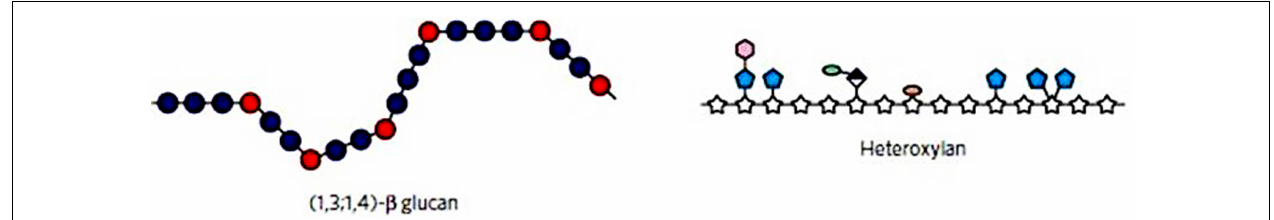
alignment and microfibril formation. In the heteroxylan (right) , intermolecular alignment of the xylan backbone (stars) and microfibril formation is limited by steric hindrance afforded by the substituents (blue, pink, etc.). Reproduced with permission from Burton etal. (2010).